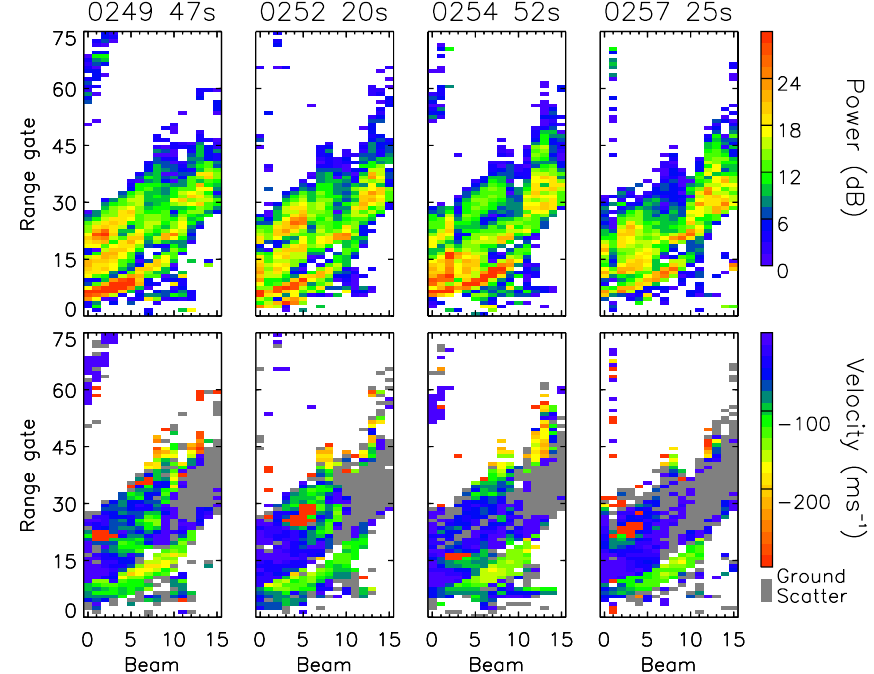
Fig. 6. Backscatter power and Doppler shift from four radar scans between 02:49 and 02:58UT. Every third scan from this interval is